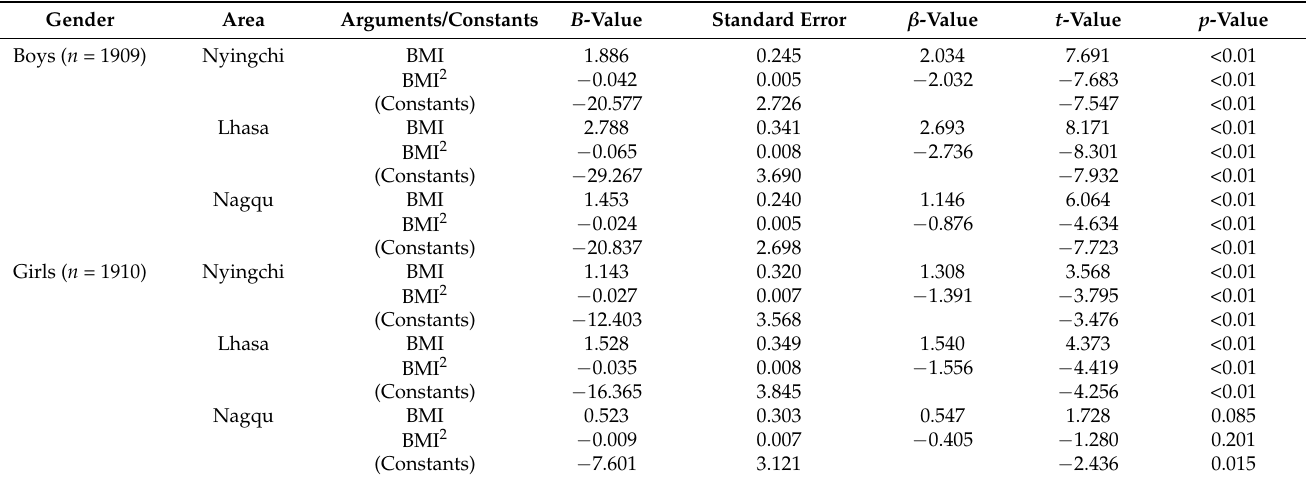
Table 3. Curve regression analysis of body mass index and PFI of Tibetan children and adolescents of different genders at different altitudes.